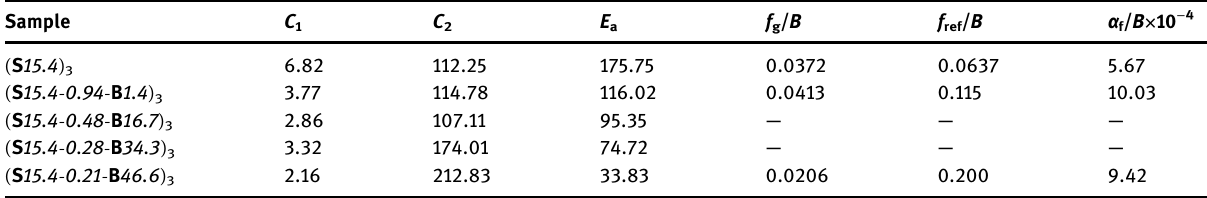
Table 3: Viscoelastic properties of all the ( PS - b - PBA ) 3 samples at T ref = 150°C determined from rheology measurement based on Arrhenius and WLF relationship